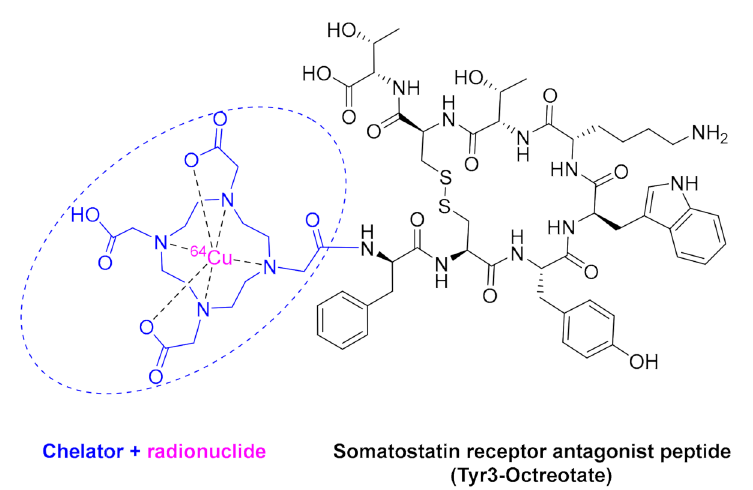
Figure 5. Structure of Cu-64